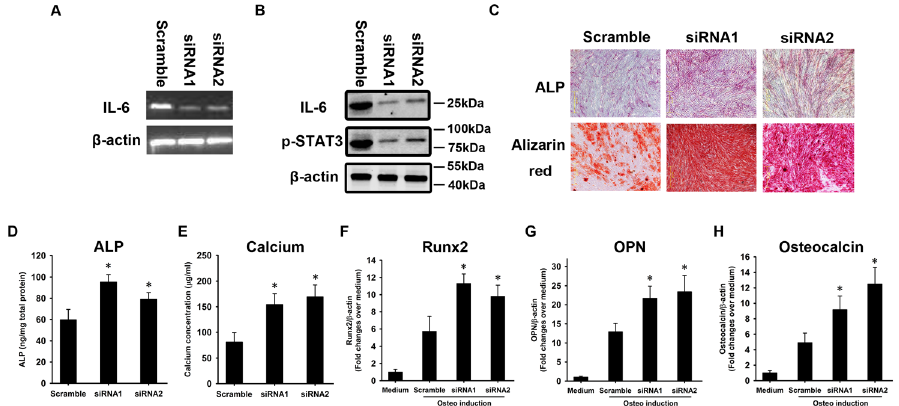
Fig 5. shRNAs against IL-6 enhance the osteogenesis of osteoporotic BMSCs. shRNAs were used to silence IL-6 expression. Silencing was confirmed by RT-PCR (A) and western blotting (B) . A scrambled sequence was used as a control. Alkaline phosphatase (ALP) and Alizarin Red staining were performed at weeks 1 and 3, respectively (C) . The quantification of ALP (D) and measurement of calcium concentration (E) were performed. At week 2, total RNA was extracted and subjected to quantitative RT-PCR using primers for Runx2 (F) , OPN (G), and OC (H) . β -actin was used as an internal control. The results are expressed as the fold-change relative to BMSCs without induction. The data are shown as the mean ± SD. * : p < 0.05, shRNA vs . scrambled